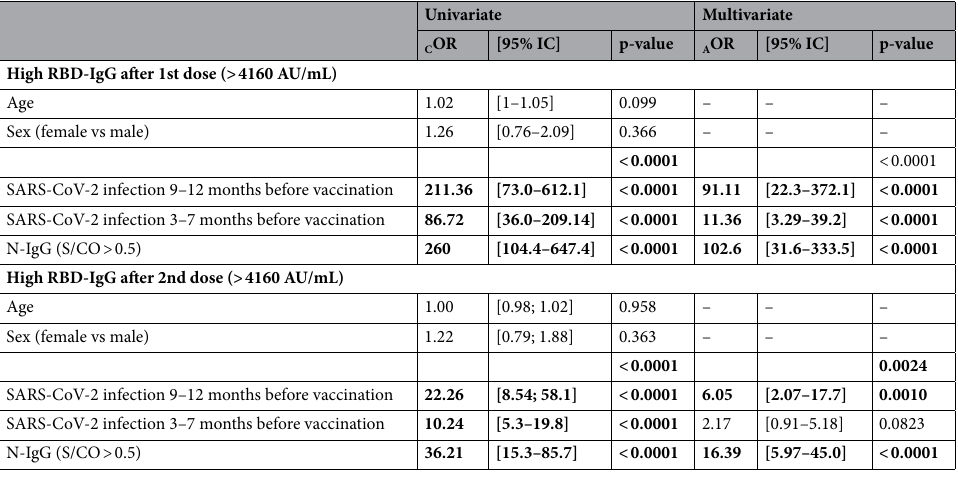
Table 2. Univariate and multivariate binomial logistic regression analyses, describing the associations between NH resident characteristics and RBD-IgG response after 1st and 2nd vaccine dose. Significant values are in bold. C OR crude OR. A OR adjusted